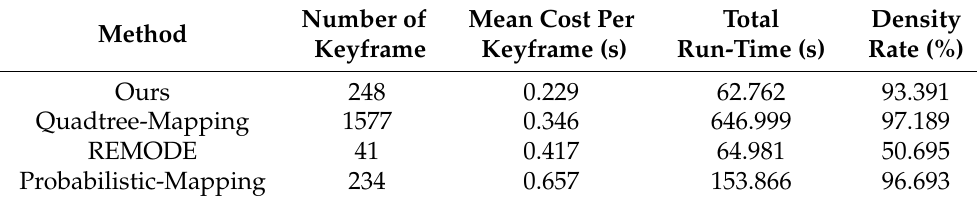
Figure 14. The runtime of the listed algorithms to generate each depth map on real-world data. Table 2. Results comparison with state-of-art method on aerial video